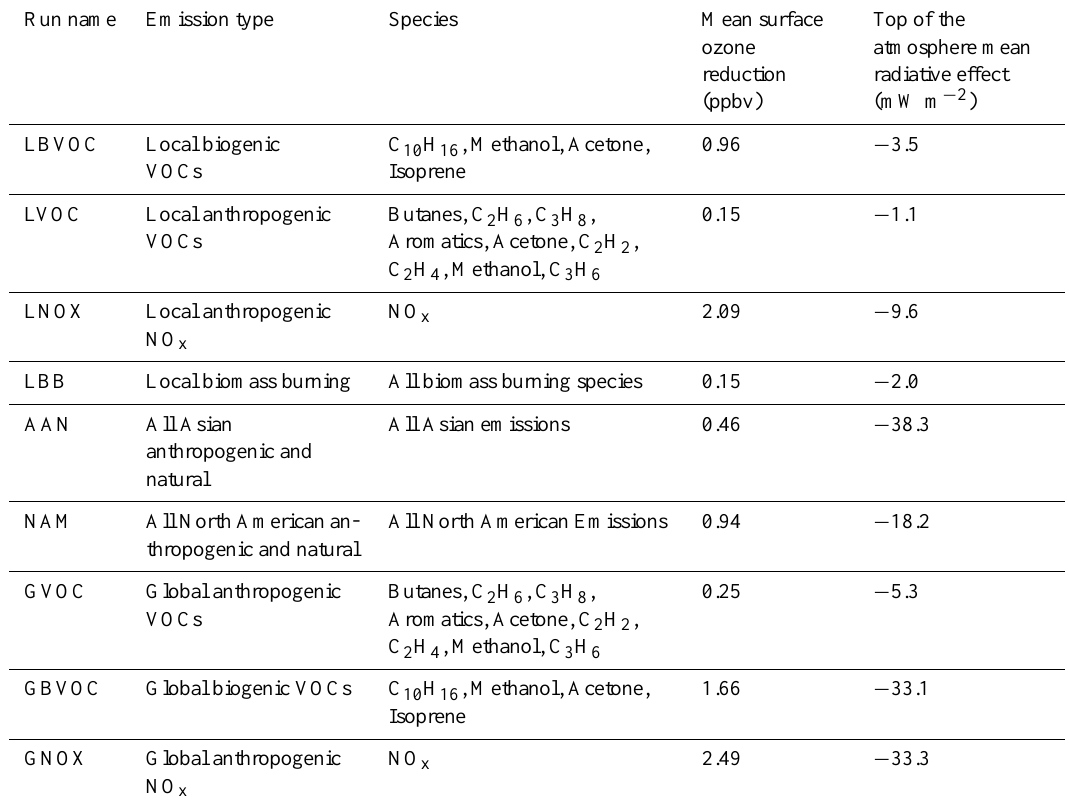
Table 2. TOMCAT sensitivity experiments performed to investigate the effect of reducing certain emissions sources by